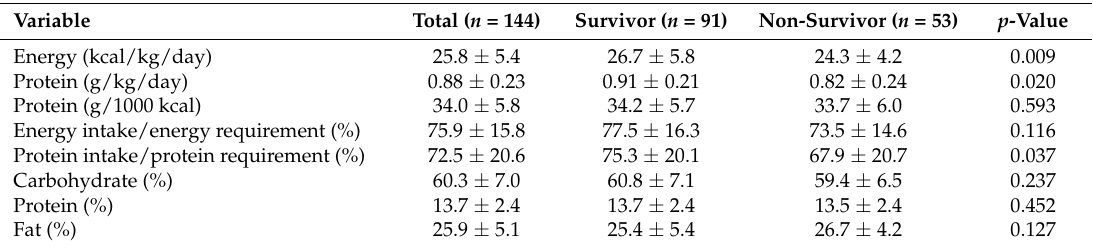
Table 4. Comparisons of nutritional intake in end-stage renal disease patients on maintenance hemodialysis. Variable Total ( n =